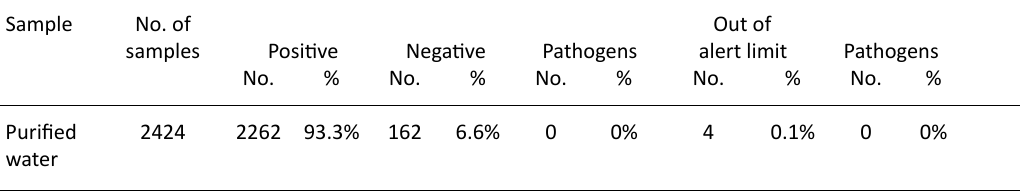
Table 2. Purified water sampling testing in pharmaceutical industry Sample